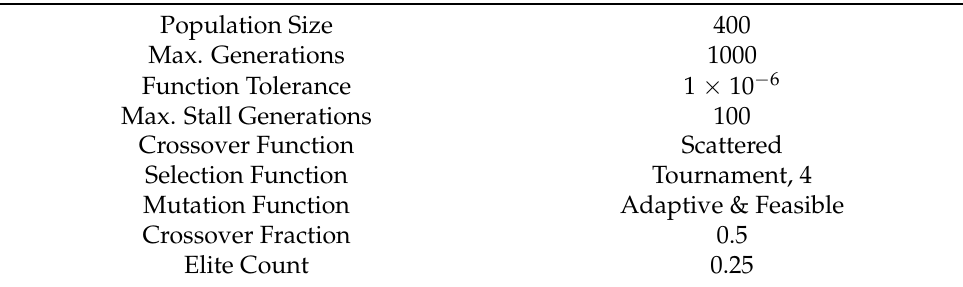
Table 1. Settings for the genetic algorithm.